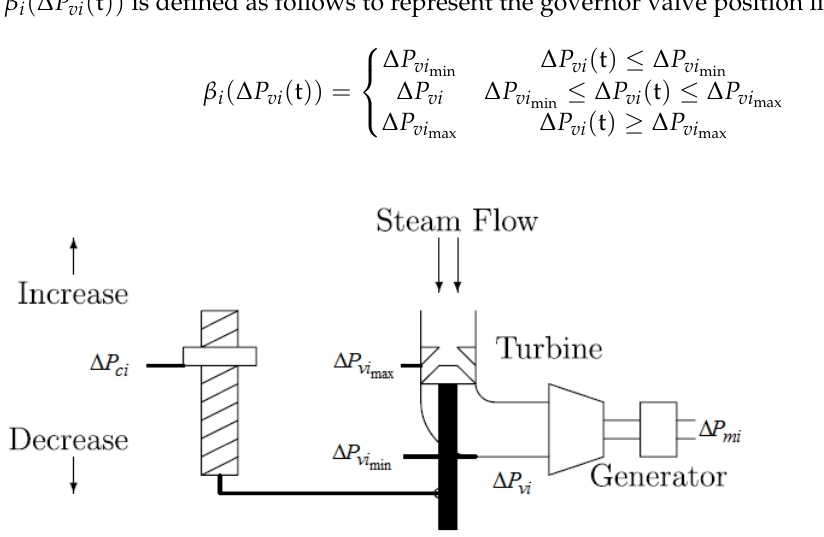
Figure 3. The typical mechanical structure of governor.